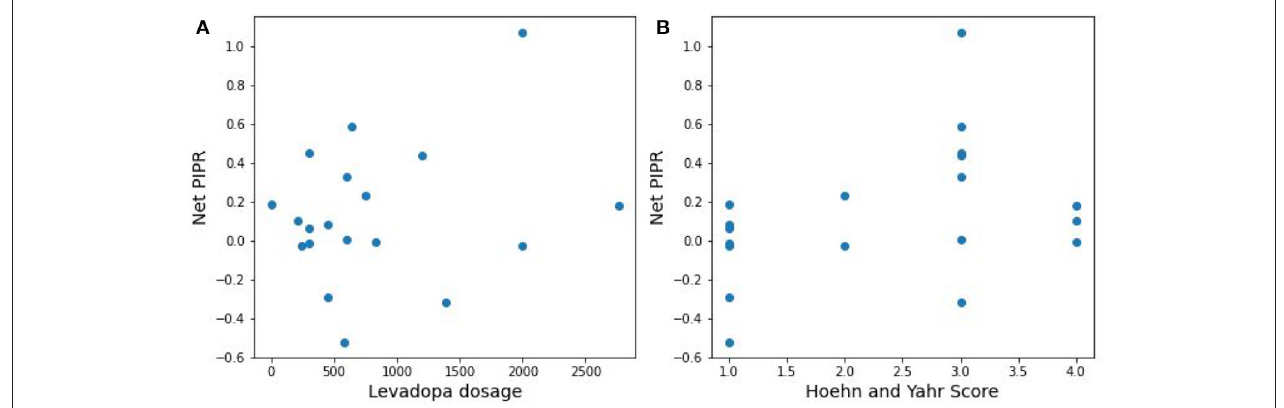
FIGURE 7 | Scatter plots of the relationship between Net PIPR and (A) levodopa dosage and (B) PD severity.